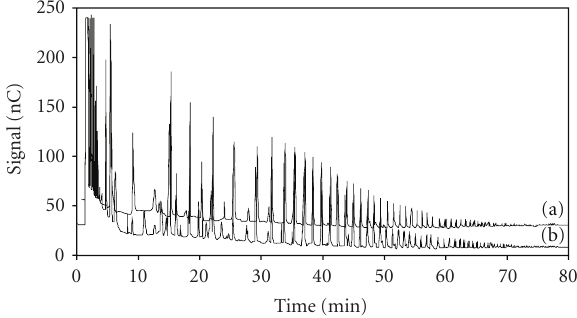
Figure 6: Chromatographic profiles of a standard solution (0.5mg mL − 1 ) of (a) Frutafit IQ compared with (b) the chromatographic profile of an extract of inulin from a cooked ham sample. Chromatographic conditions as in the text.